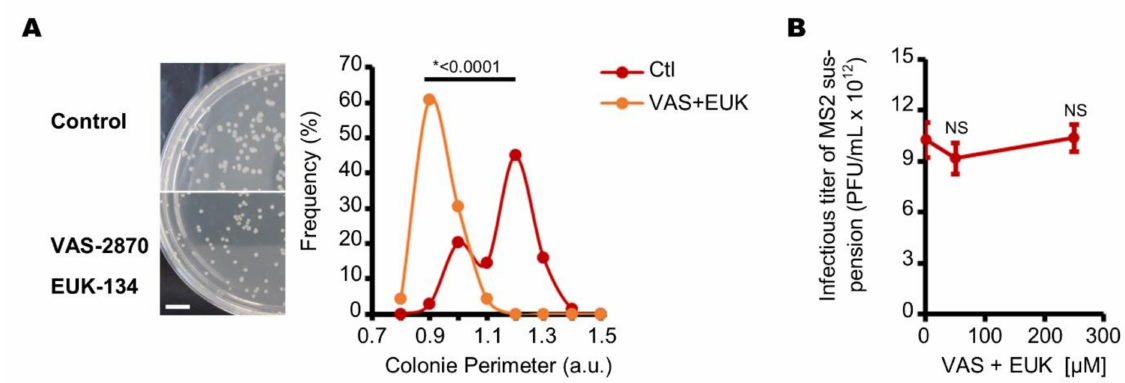
Figure 5. E. coli colonies are smaller when cultured with VAS-2870 and EUK-134 under aerobic conditions, without changing its susceptibility to infection by MS2 phages. ( A ) E. coli colonies are smaller when grown with VAS-2870 and EUK-134 compared to control, under aerobic conditions. The left panels show pictures of E. coli colonies grown on double layer agarose plates for 18 h at 37 ◦ C (scale bar corresponds to 1.0 cm). The data displayed in the right panel show the circumference distribution of 70 E. coli colonies cultured with VAS-2870 and EUK-134 (orange) and control (red) (“a.u.” stands for arbitrary unit). ( B ) the same MS2 suspension induced the formation of similar-sized plaques when cultured on a lawn of E. coli under aerobic conditions with or without VAS-2870 (50 or 250 µ M) and EUK-134 (50 or 250 µ M). In all panels, the data are representative of experiments carried out on separate days (( A ): n = 2; ( B ): n = 4). Error bars indicate standard errors. “NS” stands for statistically non-significant: p > 0.05, the statistical tests are described in the Materials and Methods